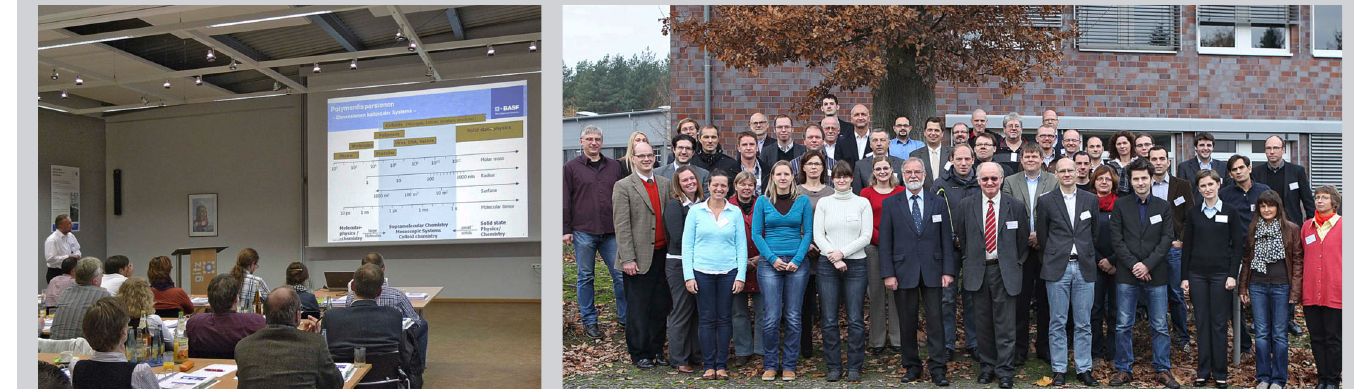
Figure 1 (left): The lecture of Meik Ranft was devoted to the “Rheolo- gy of Polymer Dispersions” (Ulrich Handge, Helmholtz- Zentrum Geesthacht). Figure 2: Around 40 participants joined the Geesthacht Poly- mer Days (Heidrun Hillen, Helmholtz-Zentrum